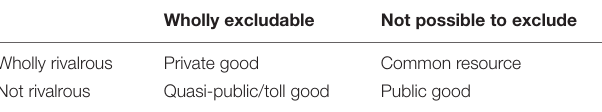
TABLE 1 | Public and private goods – traditional view. Wholly excludable Not possible to exclude Wholly rivalrous Private good Common resource Not